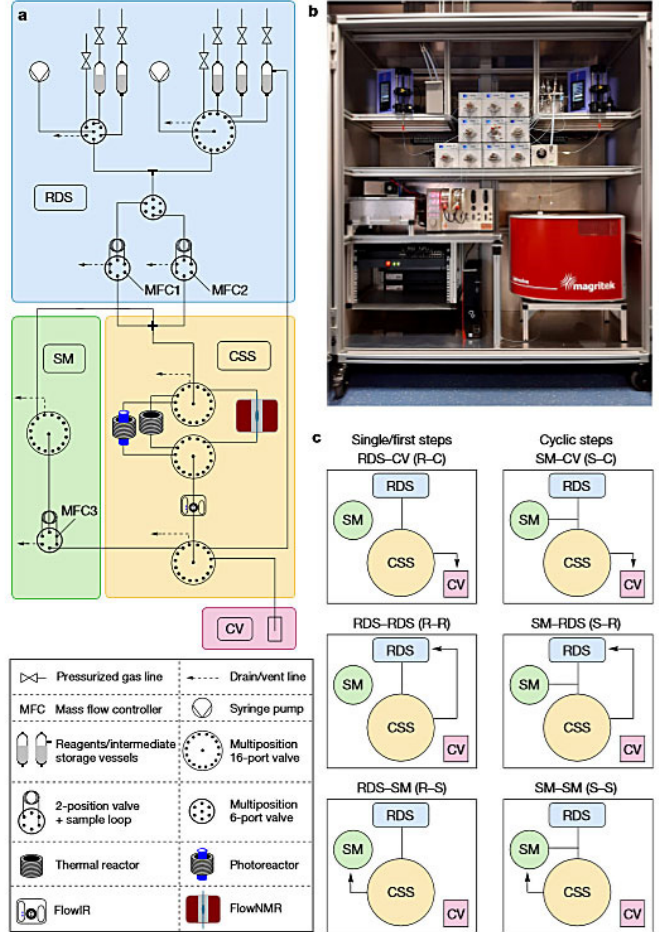
Figure 5. Radial synthesis equipment: ( a – c ). Reprinted with permission from ref. [54]. Copyright 2020, Springer Nature.